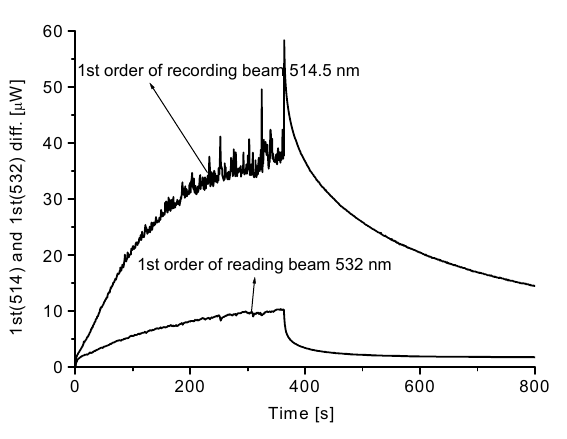
Fig. 5 Example of grating recording process in azopolymer using degenerate two-wave mixing with 514.5 nm light ( s − s polarization) and simultaneous reading with another beam at 532 nm.